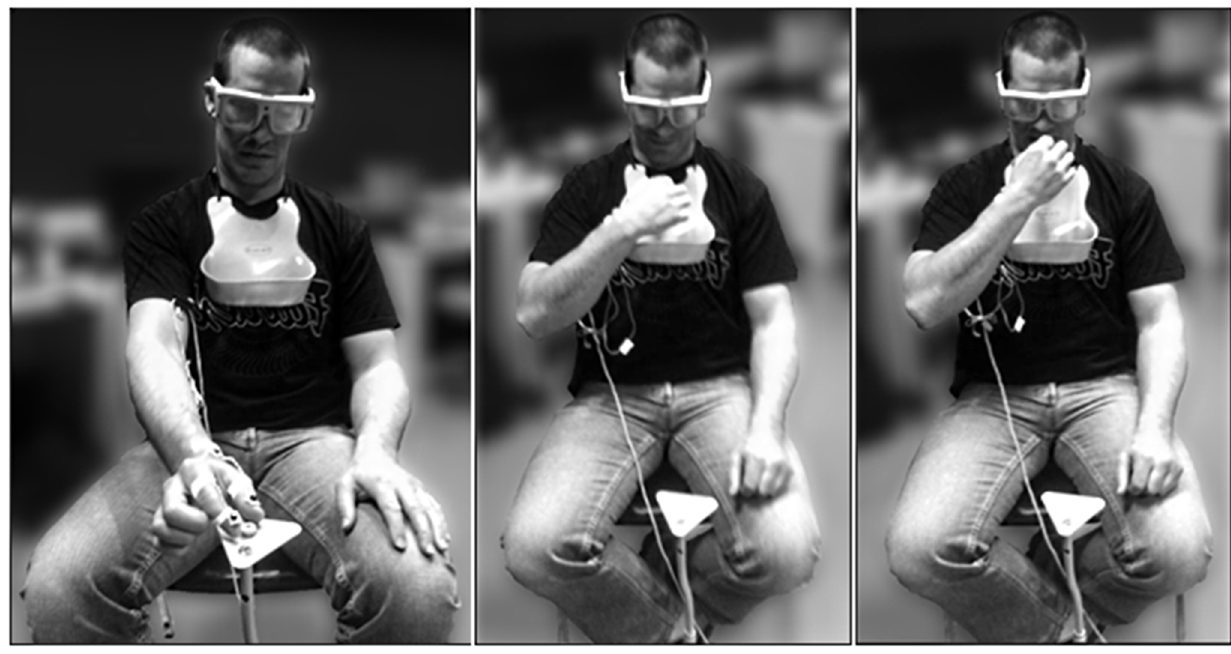
Figure 1. Experimental set-up. Left: Participant reaches-to-grasp presented target (item shown: Froot Loop H ). Center: PLACE task requires participant to grasp the target and place it in the bib hung below their chin. Right: EAT task requires participant to eat the target after grasping. Note that participants wear the bib throughout all blocks, regardless of start order or current task, and that all grasps are completed using only the index finger and thumb. The subject of this figure has given written informed consent, as outlined in the PLoS consent form, to publication of these photographs.